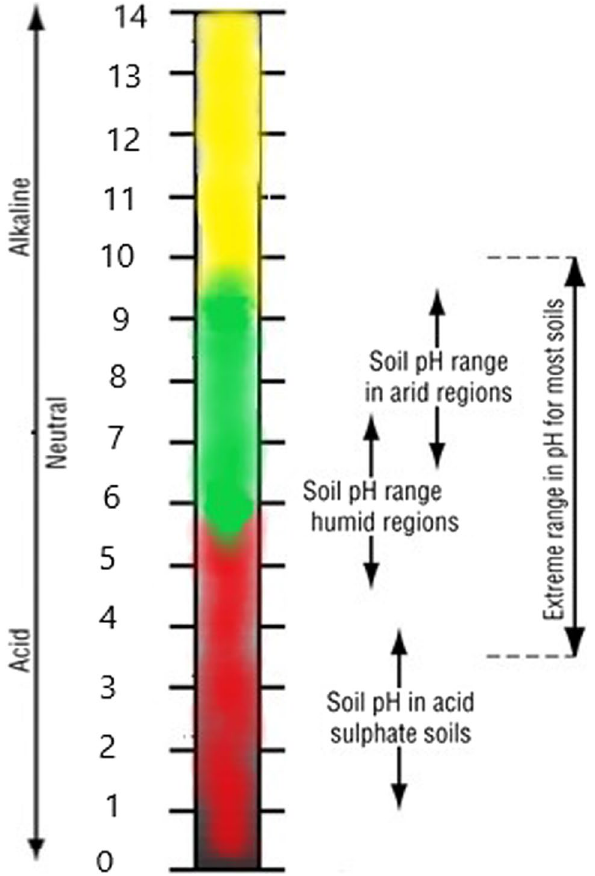
Fig. 3 pH range in soil (T. S. of Queensland 2016) Table 3 pH based soil classification (T. S. of Queensland 2016)